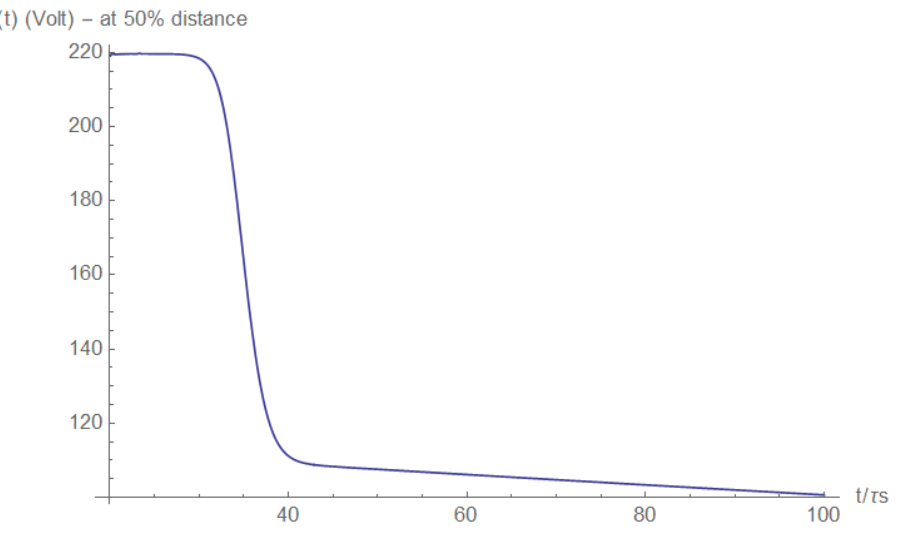
Figure A31. Voltage at half the distance between the short and the load (right after).